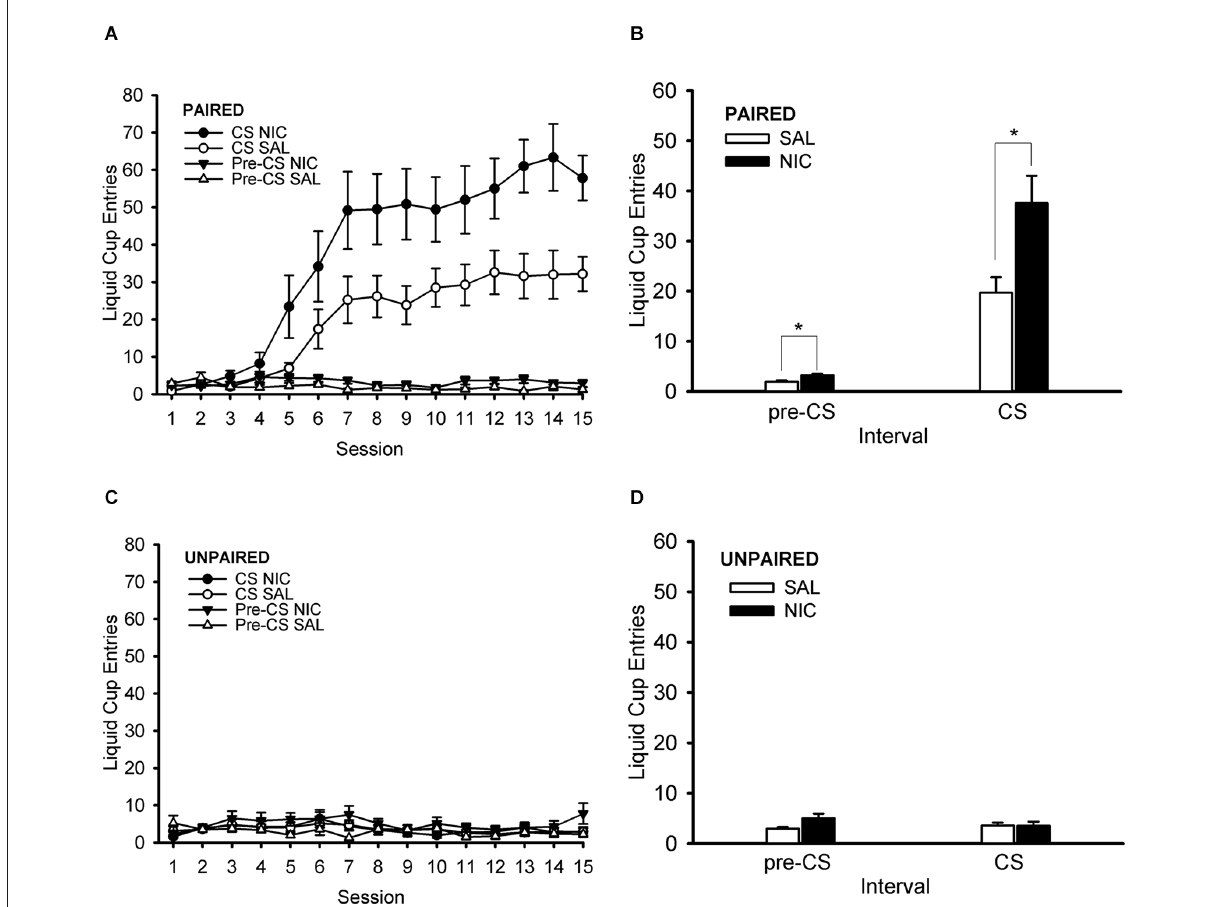
FIGURE3 Nicotine administered systemically before each Pavlovian conditioning session enhanced the Pavlovian conditioned response to an alcohol cue. Data represent the mean ( ± SEM) number of liquid cup entries per session (summed across 12 trials per session) during the first 9 s of the CS and during a 9-s pre-CS interval for the paired group (A) and the unpaired group (C) . The mean ( ± SEM) number of liquid cup entries averaged across all 15 sessions of Pavlovian conditioning during the CS and pre-CS intervals for the paired group (B) and unpaired group (D) is also displayed. Black symbols or bars denote nicotine (NIC) treatment and white symbols or bars denote saline (SAL) treatment. * p < 0.05, NIC >